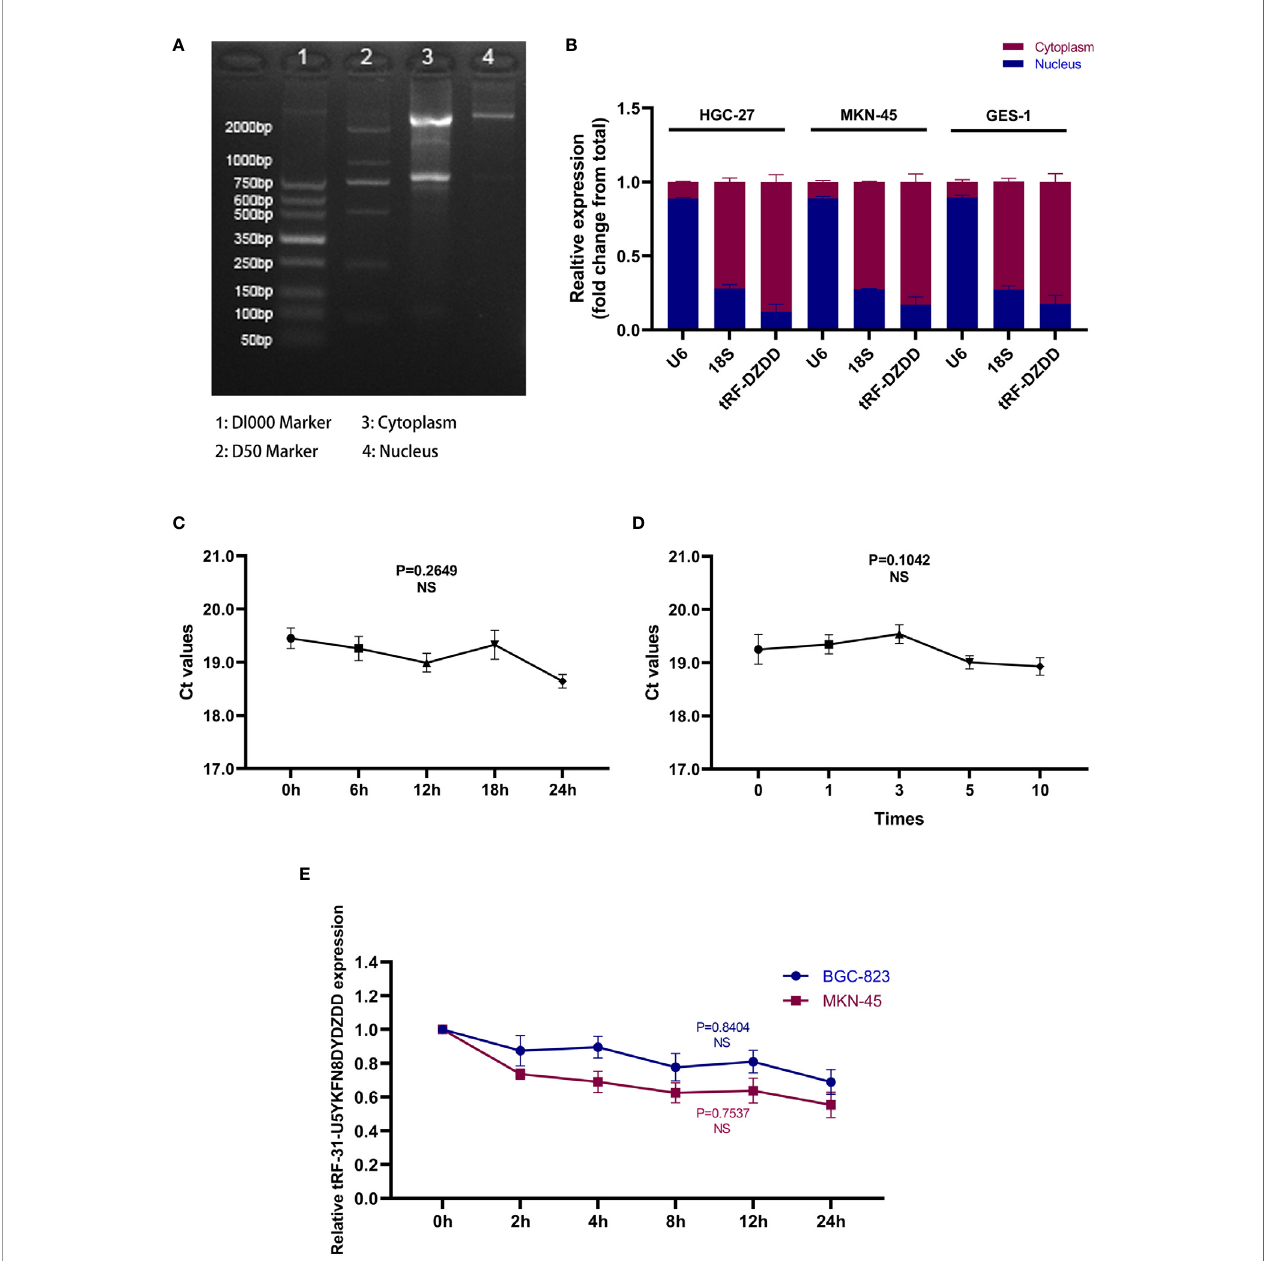
FIGURE 3 | Characteristics of the tRF-31-U5YKFN8DYDZDD as a biomarker for GC. ( A ) The RNA quality inspection of RNA Separation Assay of HGC-27 cells was detected by agarose gel electrophoresis. (B) Detection of tRF-31-U5YKFN8DYDZDD location in HGC-27, MKN-45, and GES-1 cell lines by Nuclear and Cytoplasmic RNA Separation Assay. (C, D) The good stability and repeatability of tRF-31-U5YKFN8DYDZDD were con fi rmed by qRT-PCR. (E) qRT-PCR for abundance of tRF- 31-U5YKFN8DYDZDD in in BGC-823 and MKN-45 cell lines treated with Actinomycin D at the indicated time